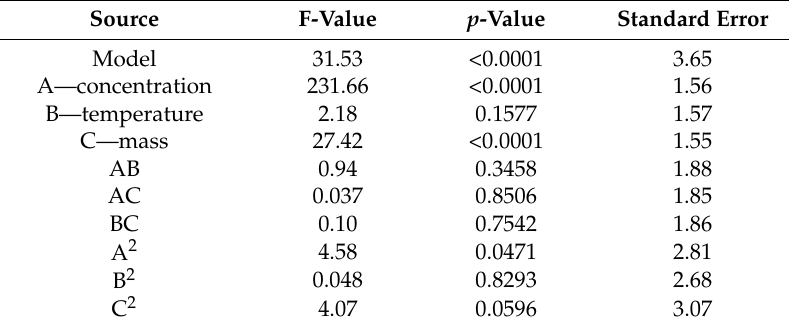
Table 5. Estimated regression coefficients for response surface model.